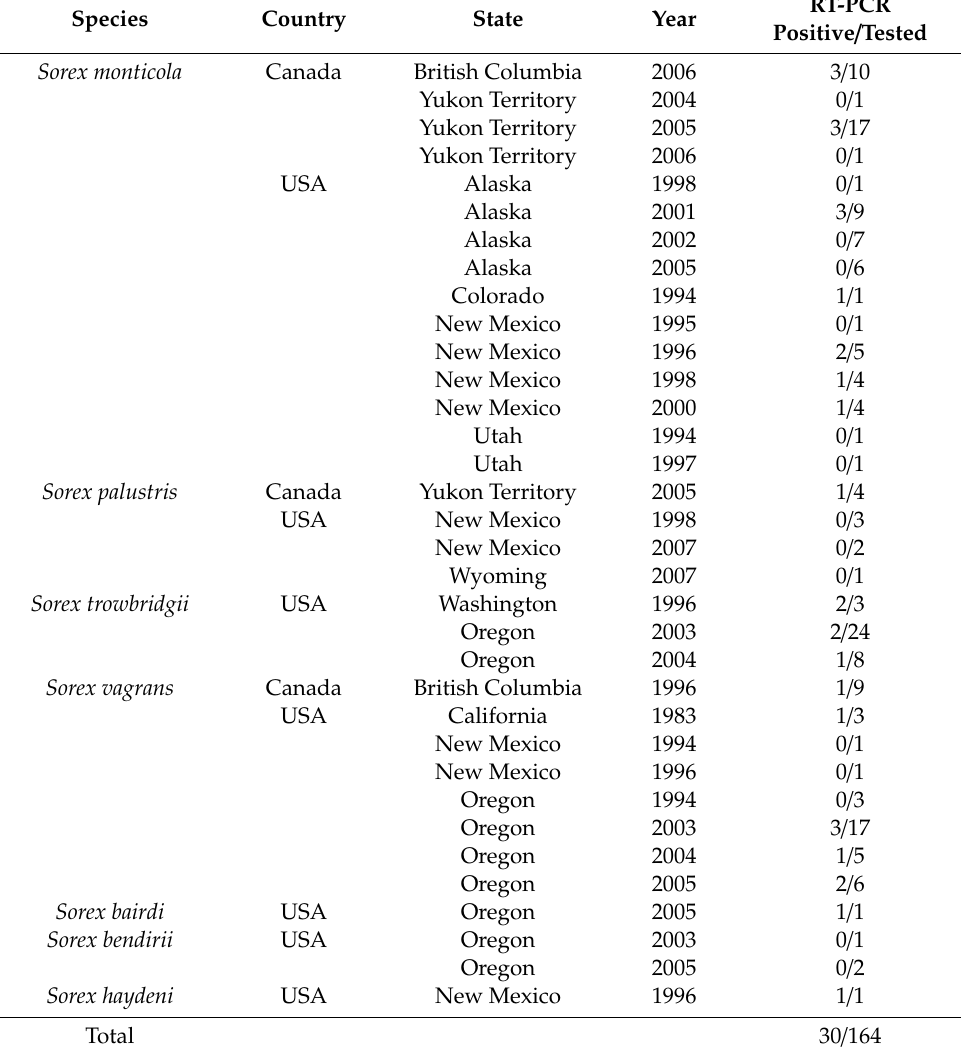
Table 1. RT-PCR detection of orthohantavirus RNA in tissues of soricine